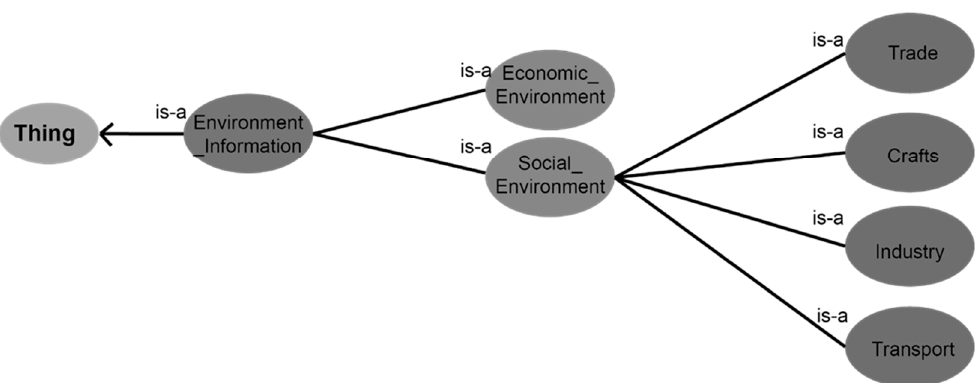
Figure 2. Regional_environment concept.